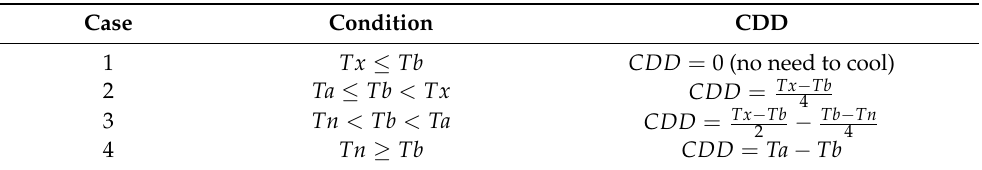
Table 3. Calculation of daily CDD values by comparing the maximum and minimum temperatures relative to the base temperature (Tb)